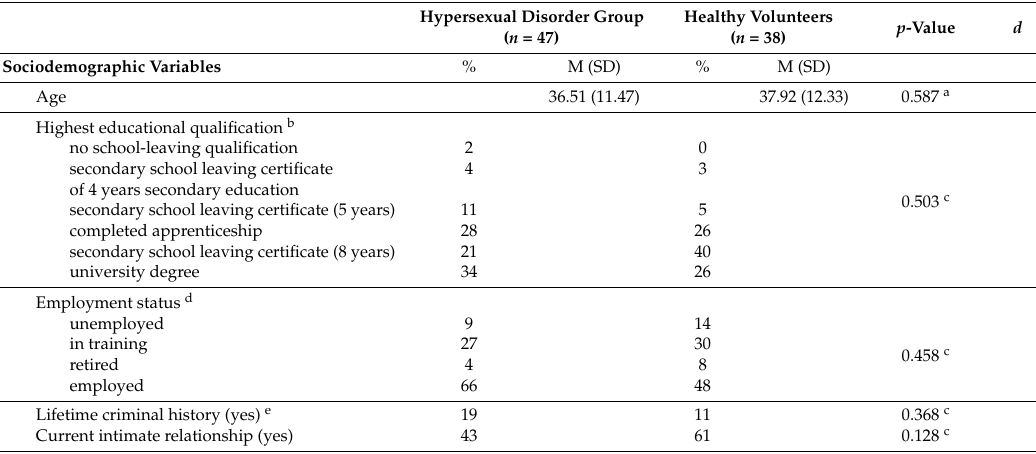
Table 1. Sociodemographic, neurodevelopmental, and family